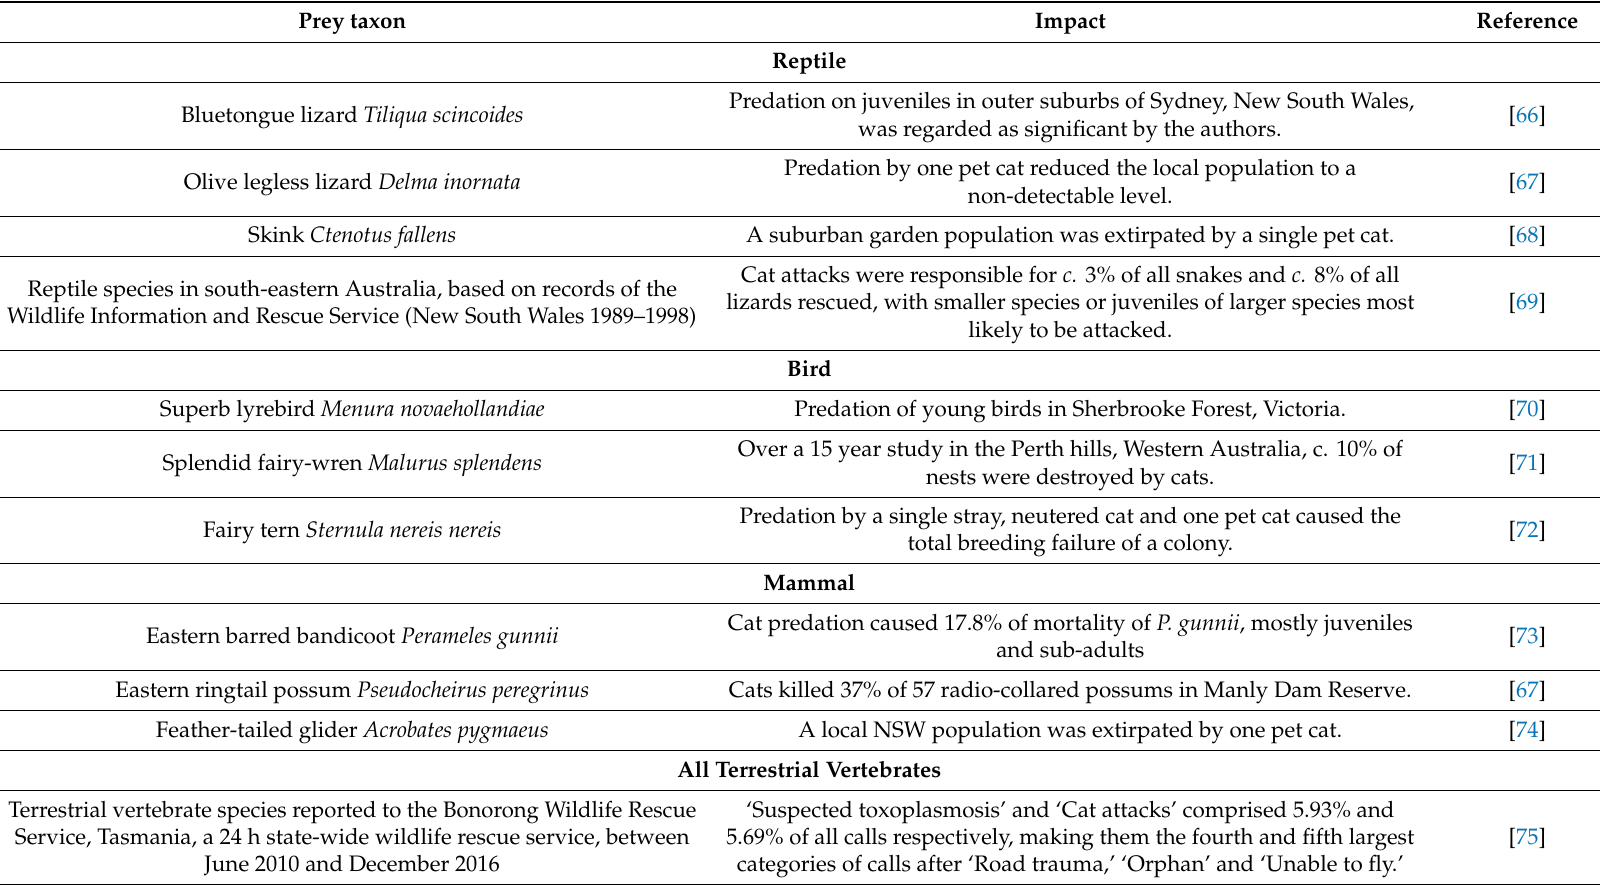
Table 1. Examples of significant predation pressures by pet or stray cats on wildlife in